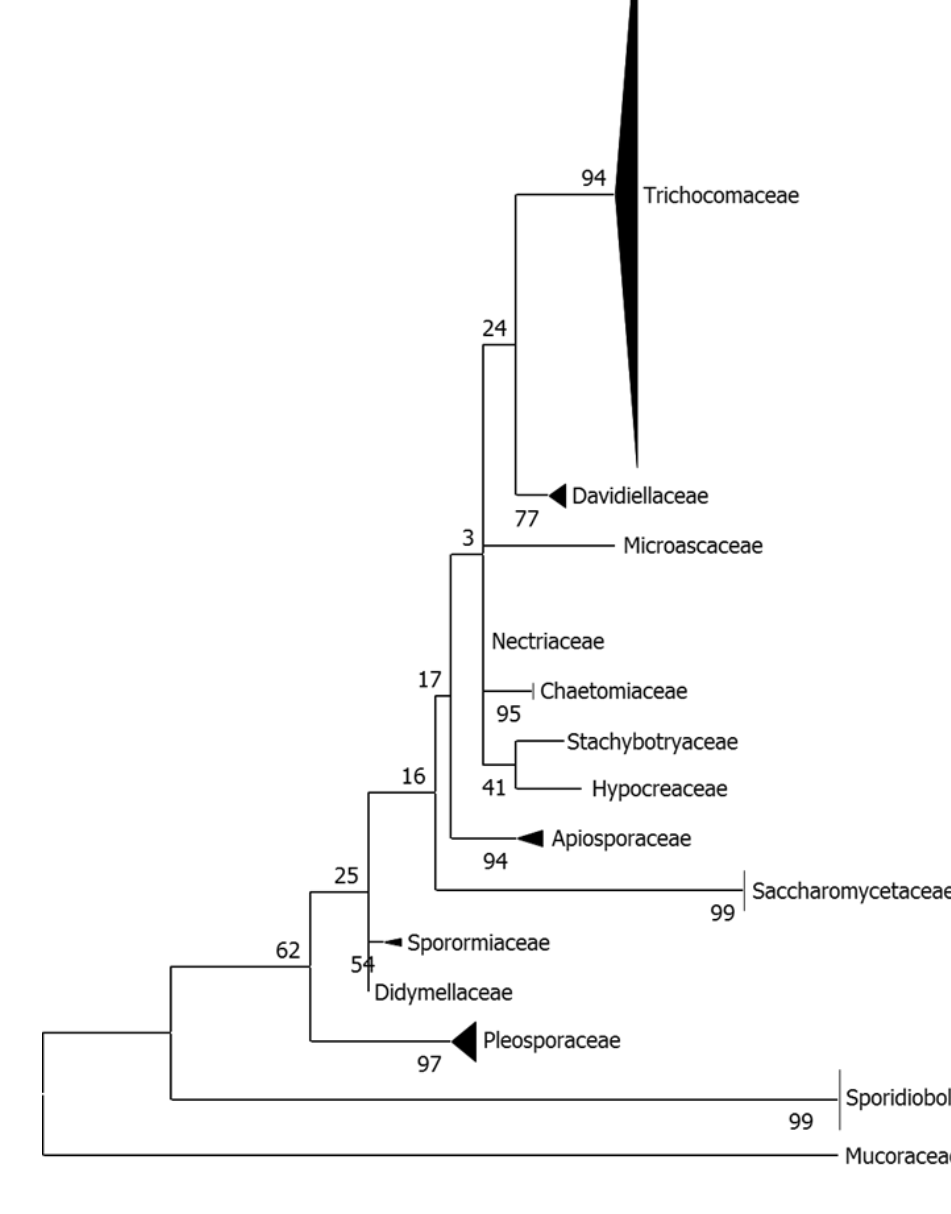
Figure 2. Phylogenetic tree describing the relative abundance of fungal family representatives isolated from Acropora loripes . Molecular Phylogenetic analysis was carried out by Maximum Likelihood method. The tree is drawn to scale, with branch lengths measured in the number of substitutions per site. Evolutionary analyses were conducted in MEGA7.